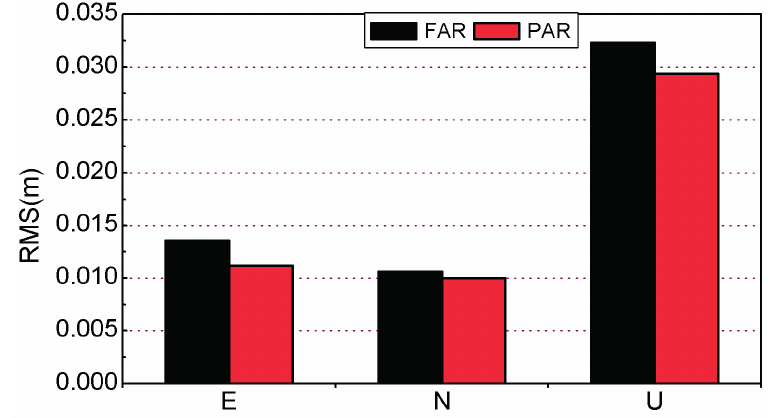
Figure 12. The average RMS of station position in east, north and up directions for kinematic PPP with the FAR and PAR